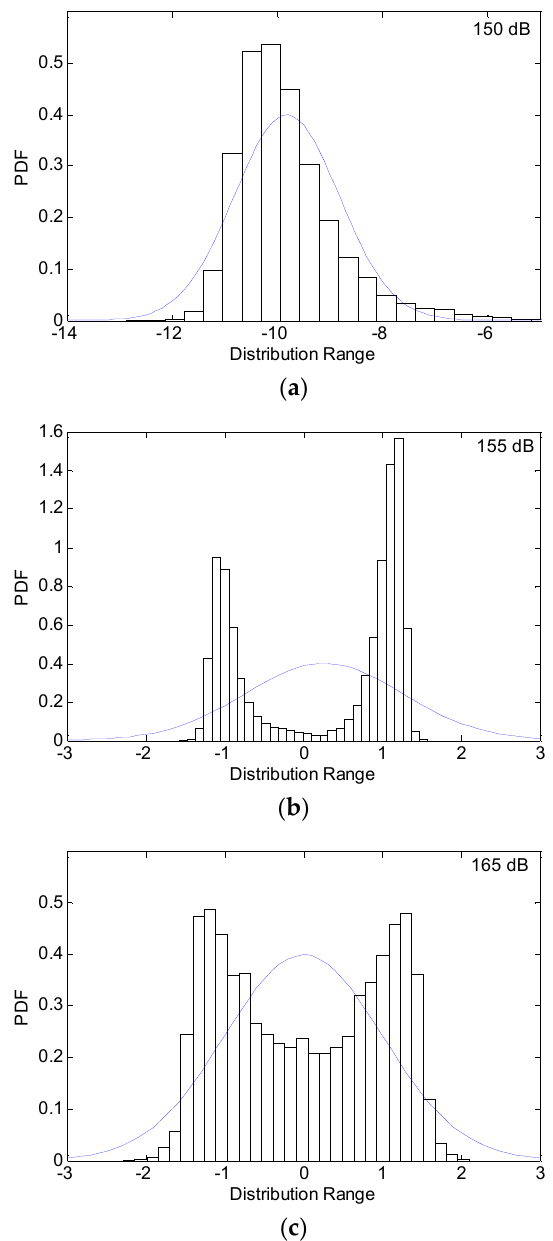
Figure 5. PDF of the transverse displacement response at the center of the thermally post-bucked panel at 600 °C. ( a ) 150 dB; ( b ) 155 dB; ( c ) 165 dB.